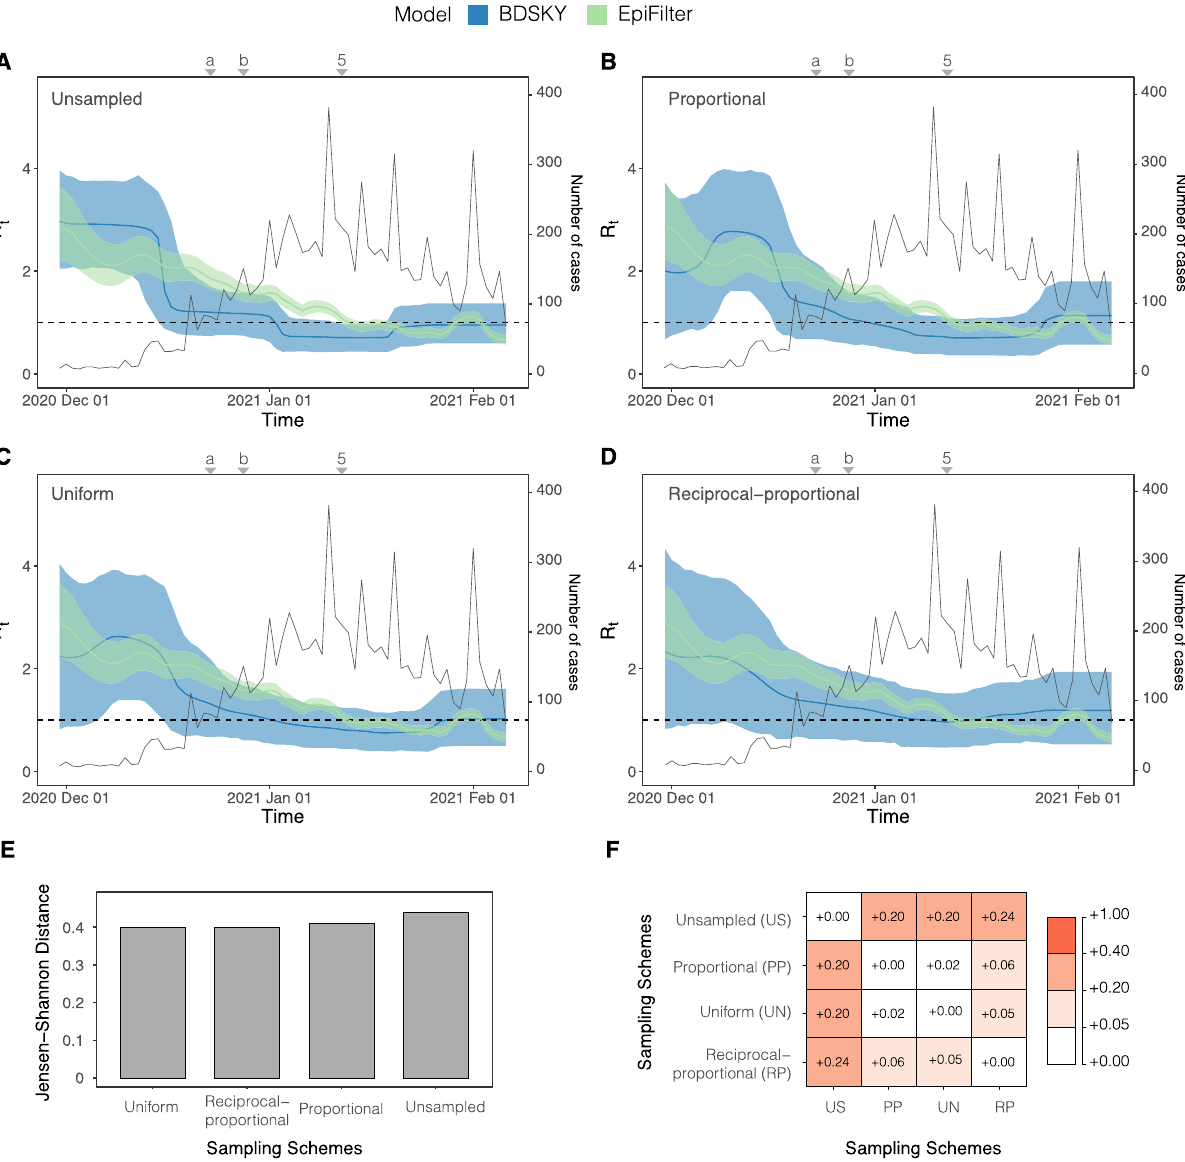
commercial activities in Manaus 52 . The Jensen Shannon Distance (JSD) is given in panel E and ranks the sampling strategies based on how similar the BDSKY esti- matesunderthosestrategiesaretothosederivedfrom EpiFilter (smallervaluesare better). Panel F provides the pairwise JSD between the BDSKY estimates under different sampling strategies, showing often appreciable difference among